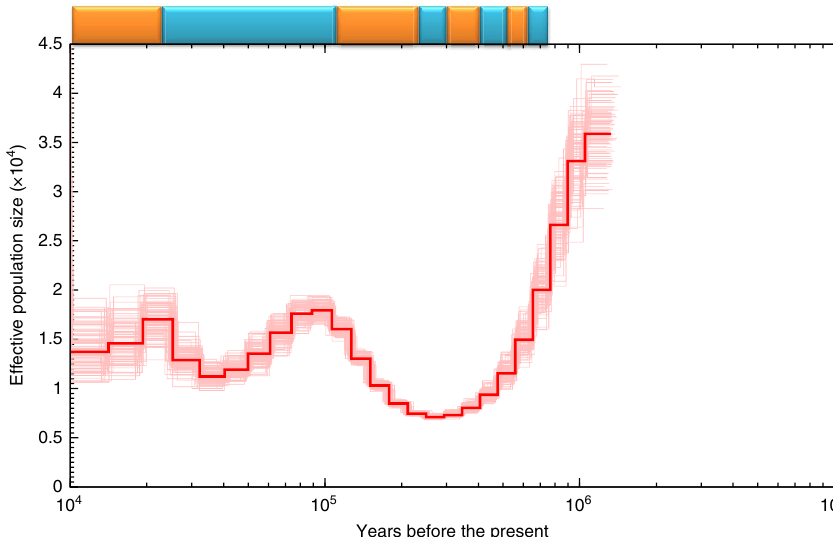
Figure 2 | Inference of channel catfish population history. The central bold line represents inferred population size, and the 100 thin curves surrounding the central line are PSMC estimates generated using 100 sequences randomly resampled from the original sequence. The mutation rate of 2.5e (cid:2) 8, adopted from medaka 64 , was used in time scaling. Blue bars at the top of the figure represent glacial periods and orange bars, interglacial periods.